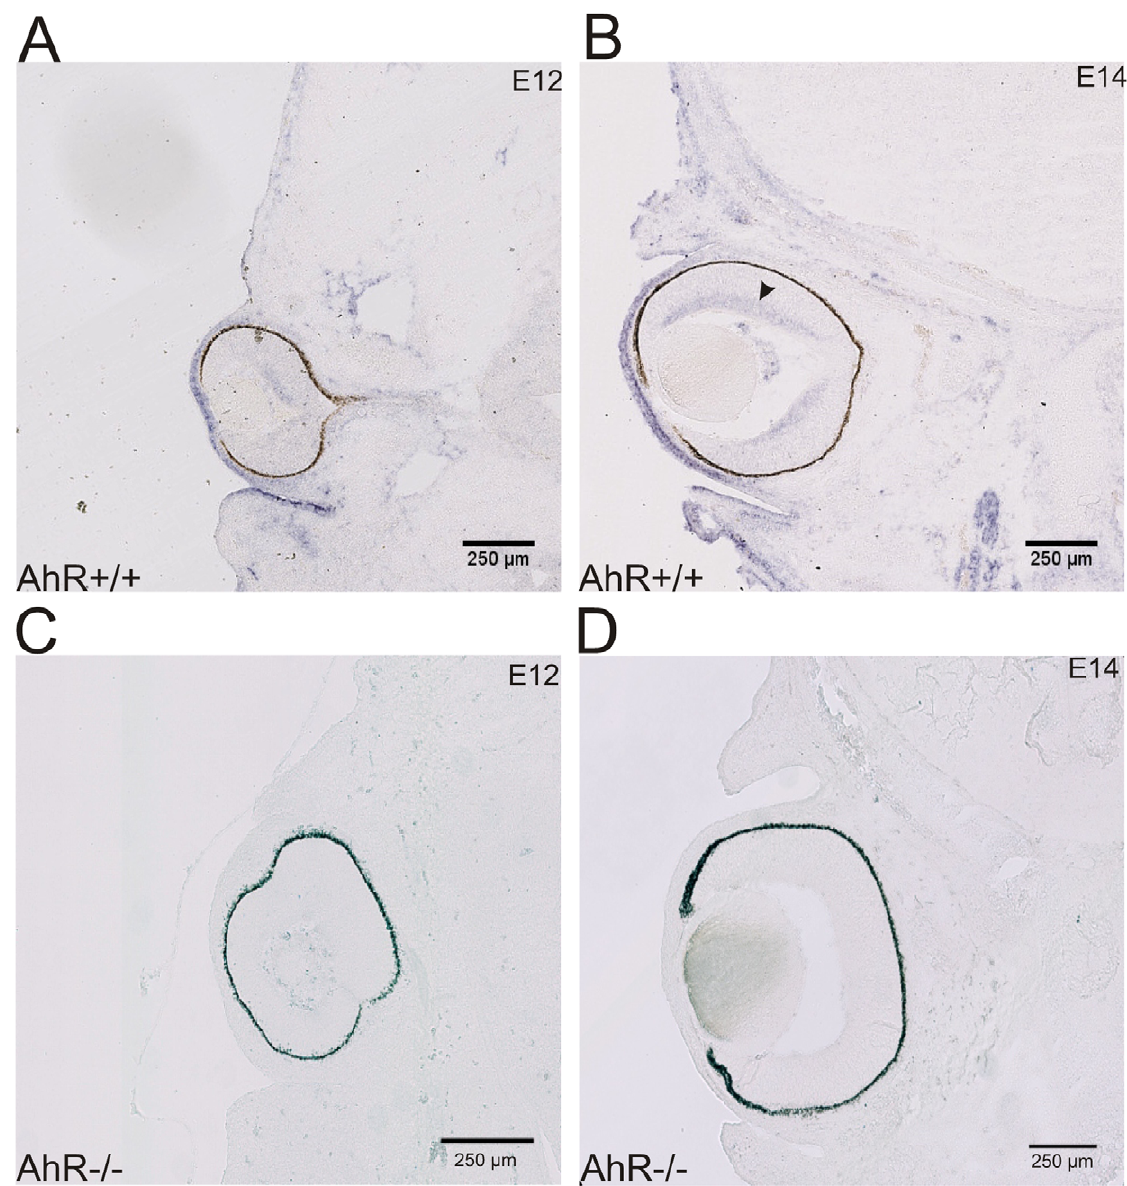
Figure 5. The AhR is expressed in the eyes during the development of AhR + / + mice. In situ hybridization is performed on coronal sections of the mice eyes at two embryonic stages (E12 and E14) with digoxigenin-labeled riboprobes for AhR. (A & C) E12 coronal section of AhR + / + (A) and AhR 2 / 2 mice (C); no expression of AhR is detected at this stage. (B & D) E14 coronal section of AhR + / + (B) and AhR 2 / 2 mice (D); the black arrow (in B) indicates the expression of AhR in the retinal ganglion cells. Scale bar represent 250 m